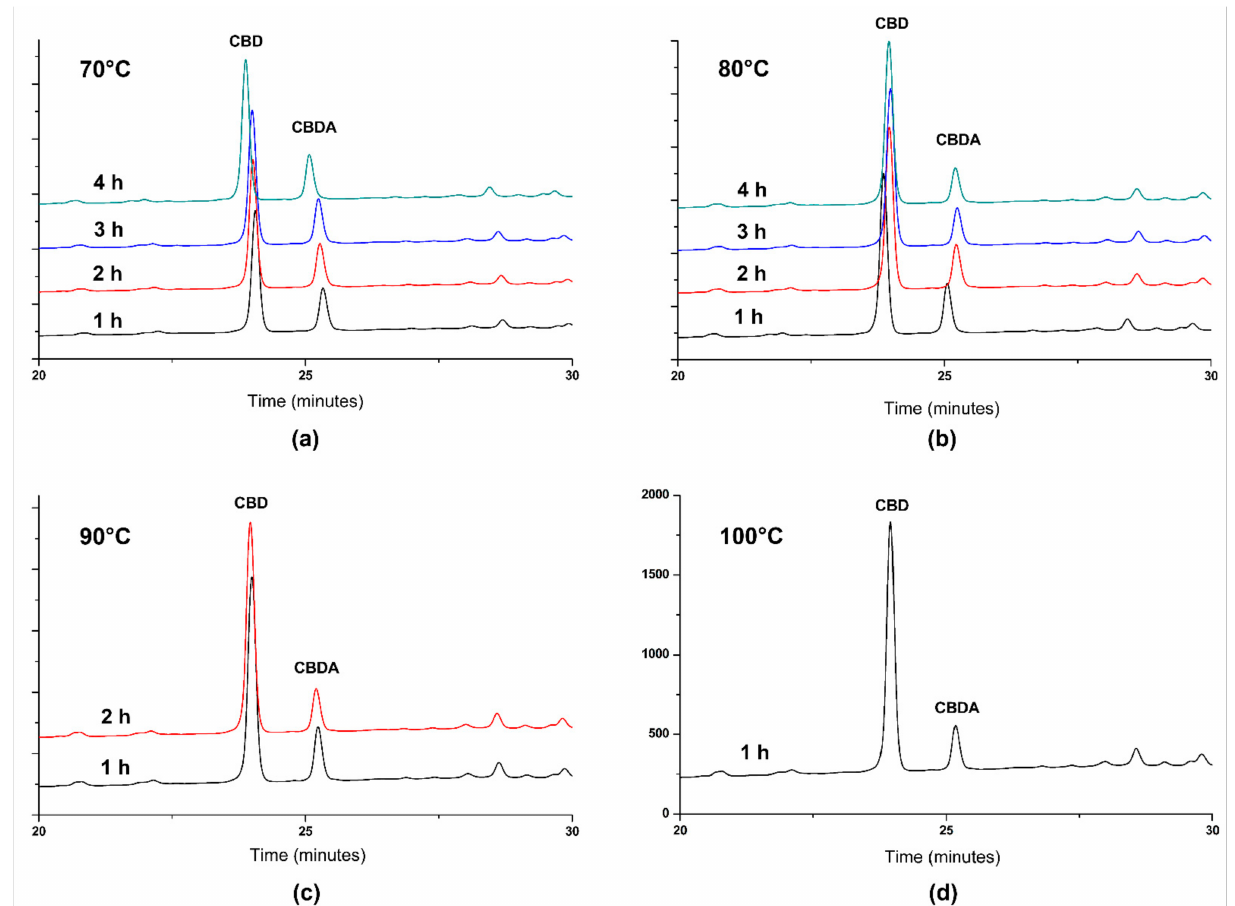
Figure 4. Representative HPLC chromatograms for decarboxylated hemp oil in different soft conditions: ( a ) 70 ◦ C; ( b ) 80 ◦ C; ( c ) 90 ◦ C; ( d ) 100 ◦ C. CBD: cannabidiol, CBDA: cannabidiolic